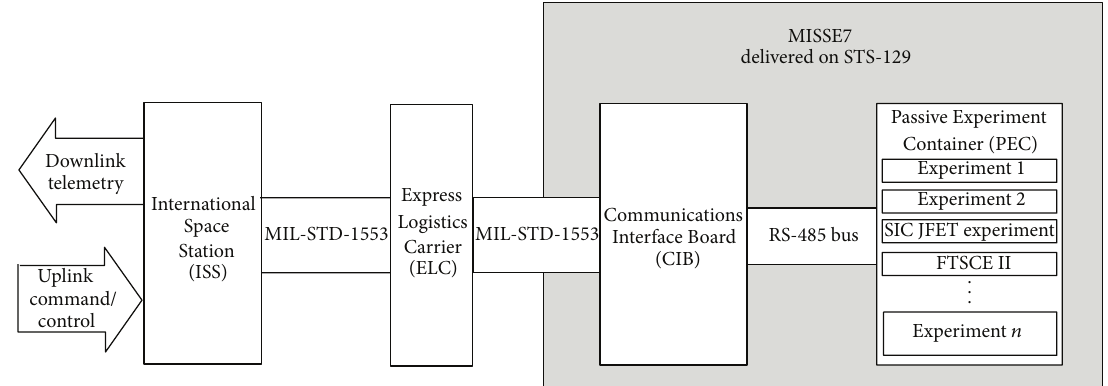
Figure 1: Diagram of the MISSE7 communication architecture and interface to the International Space Station telemetry through the Express Logistics